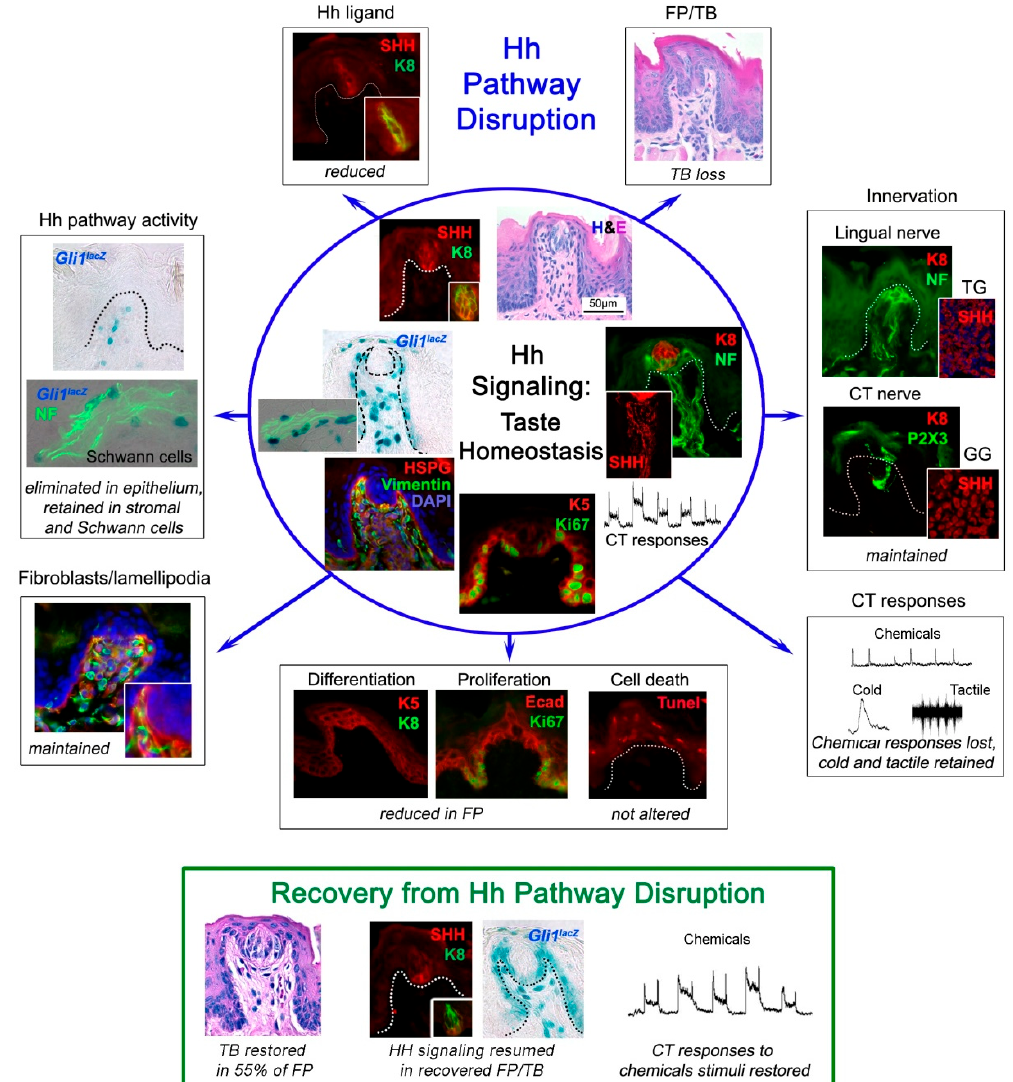
Figure 2. Summary of effects as follows: Hh Signaling Regulation in Taste Homeostasis; Hh Pathway Disruption; and, Recovery from Hh Pathway Disruption. Blue Circle, Inside: Hh signaling regulation in maintaining taste organs and sensation. Hh Signaling in Taste Homeostasis is illustrated in the fungiform papilla taste organ (FP), taste bud (TB), and Shh ligand (top); papilla and taste bud innervation and chorda tympani (CT) neurophysiological responses (right); taste organ cell functions (bottom); connective tissue fibroblasts (bottom left); and Hh pathway activity in papilla epithelium and stroma (left). Blue Circle, Outside: Effects of Hh Pathway Disruption by genetic suppression or pharmacologic inhibition. With Hh Pathway Disruption, blue arrows followed from the top and proceeding clockwise, there is the following: taste bud loss and associated reduction of Shh ligand (top); maintained innervation and ganglion neurons; elimination of taste responses but retained responses to cold and touch; reduced cell proliferation, compromised differentiation with unaltered cell death; sustained fibroblast/lamellipodia activity; and, loss of Hh signaling in the papilla epithelium, but retention in the connective tissue core. Green Box: Recovery from Hh Pathway Disruption. The following occurs after pathway disruption is discontinued: TB are restored in about 55% of FP; Hh signaling is resumed in epithelium of recovered FP; and, taste responses are restored. (Results in the figure are drawn principally from hematoxylin and eosin staining, immunohistochemistry, X-gal staining, and electrophysiology. Effects are illustrated with the FP/TB but apply also to the circumvallate papilla and taste buds). Some of the images for Taste homeostasis (inside Blue Circle), Hh pathway disruption (outside of the Blue Circle), and the entire Recovery panel (Green Box) are extracted from Figures in Kumari et al. 2017 [6] with permission. Scale bar in H&E image within the blue circle applies throughout.4.2. Hh Signaling Disruption with Genetic